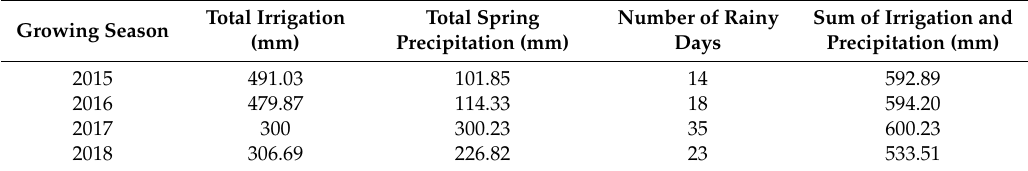
Table 1. Levels of precipitation during the spring (February-June) and irrigation in the vineyard during the four growing seasons.